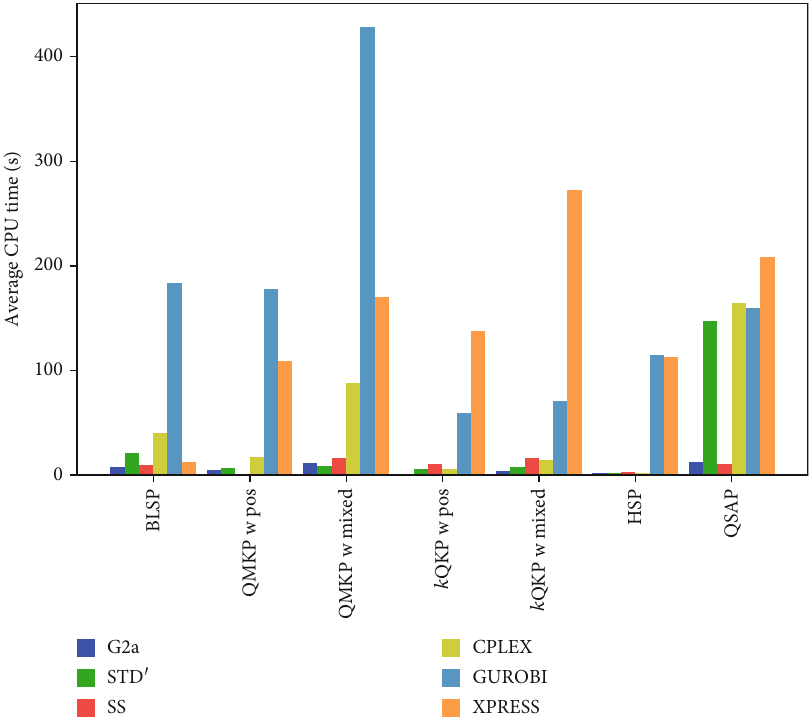
Figure 10: Average CPU times (s) for all